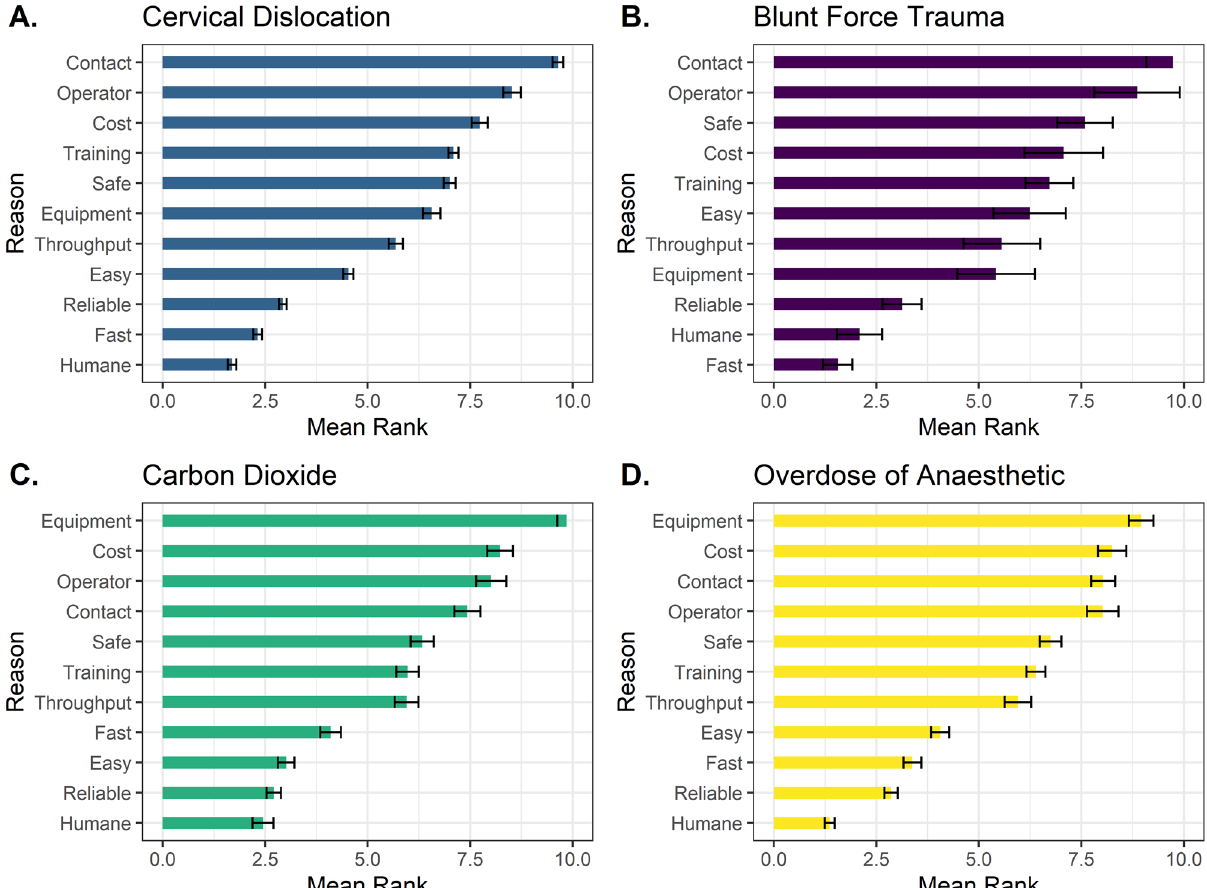
Figure 6. Mean (± SE) rank for each reason underpinning preferred Schedule 1 methods. Reasons were ranked in order of importance from 1 to 11 with 1 being most important and 11 being least important (219 respondents). Please note y axis of characteristics vary for each method, allowing for them to listed in order of importance for each